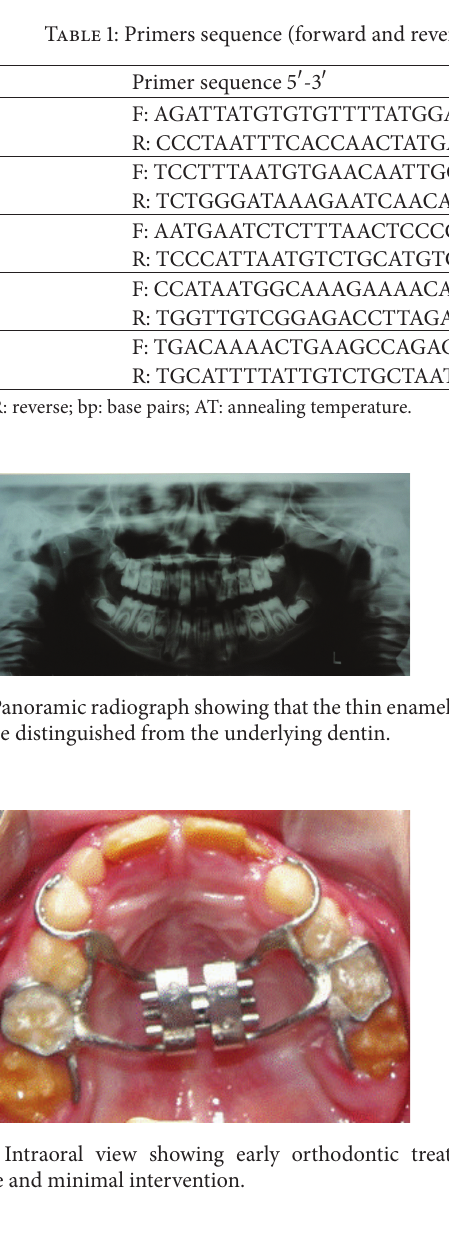
Figure 6: (a), (b), and (c)-Intraoral view showing the restorative treatment and esthetic appearance of the